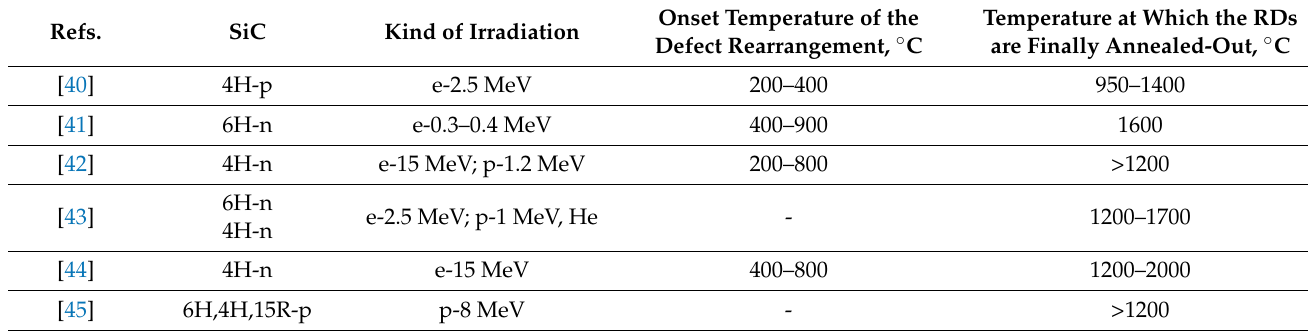
Table 2. Annealing temperatures of radiation defects in SiC after various kinds of irradiation [38]. Refs.